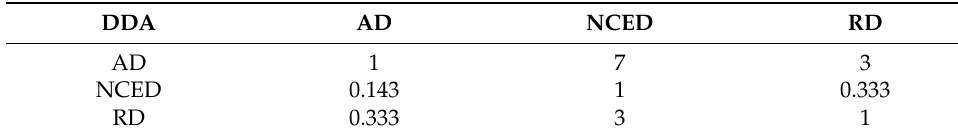
Figure 10. Two hierarchy levels. Table 5. DDDI pairwise matrix.